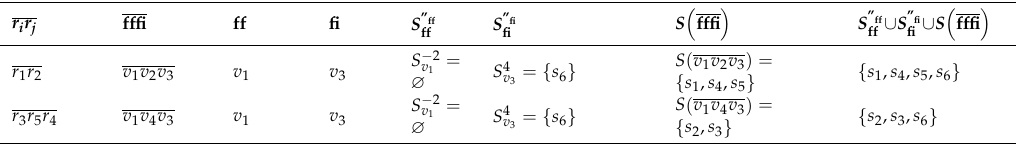
Table 4. Computation of R (cid:46)(cid:47) ε S using the EDISON